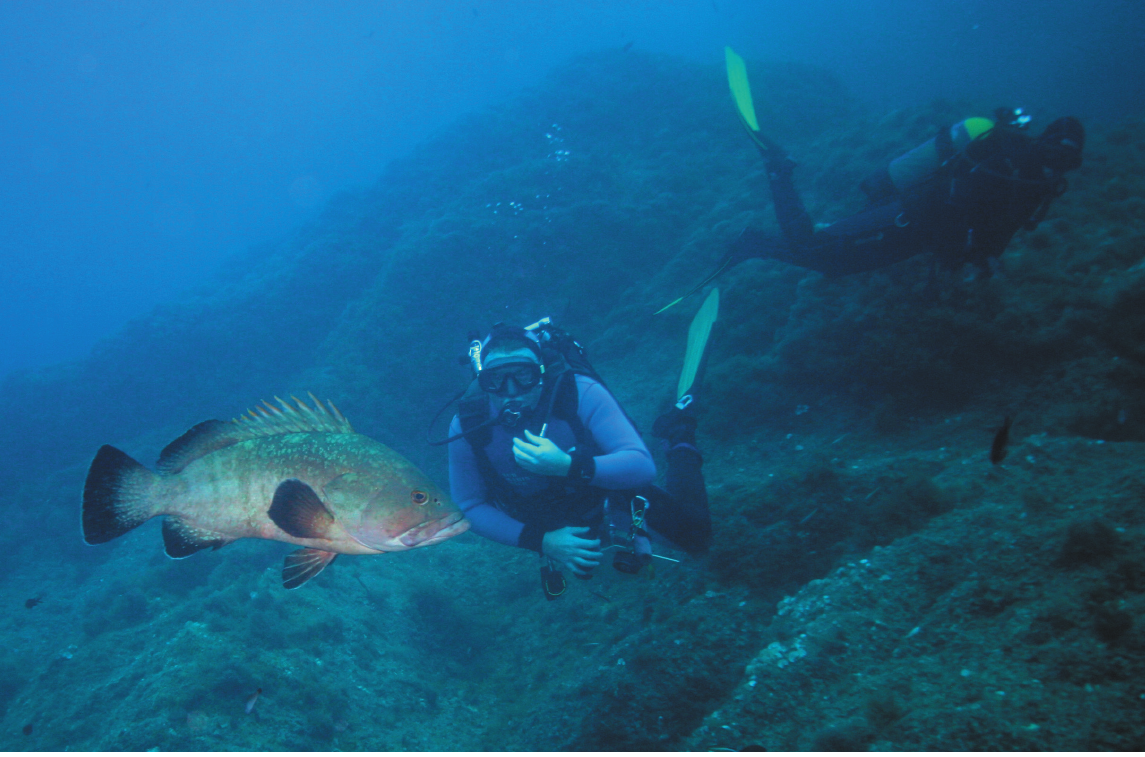
Fig. 4. Patrice Francour counting groupers in Port-Cros National Parc 2009; © J.M.